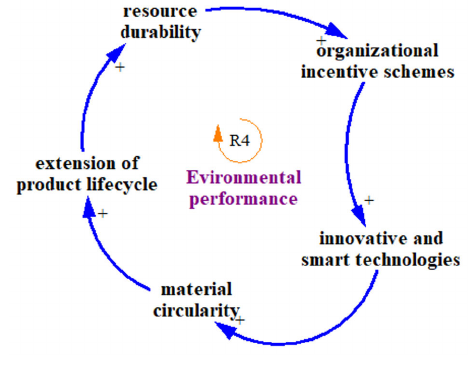
Figure 9. Reinforcing loop R4.